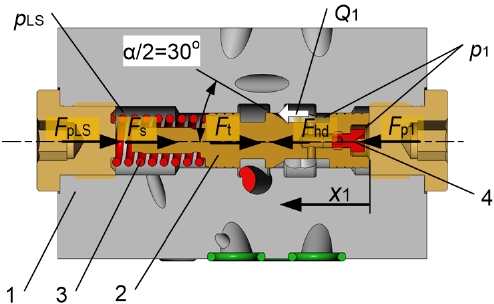
Figure 3. Longitudinal cross-section of the differential valve: 1—valve body, 2—spool, 3—spring, 4—damping nozzle; in, out—connecting ports, α /2—half of the cone opening angle, x 1 —spool